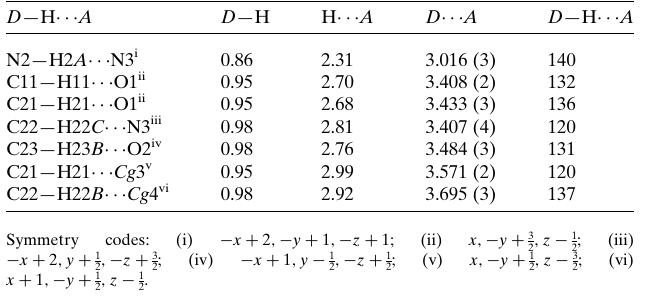
Table 2 Experimental details.